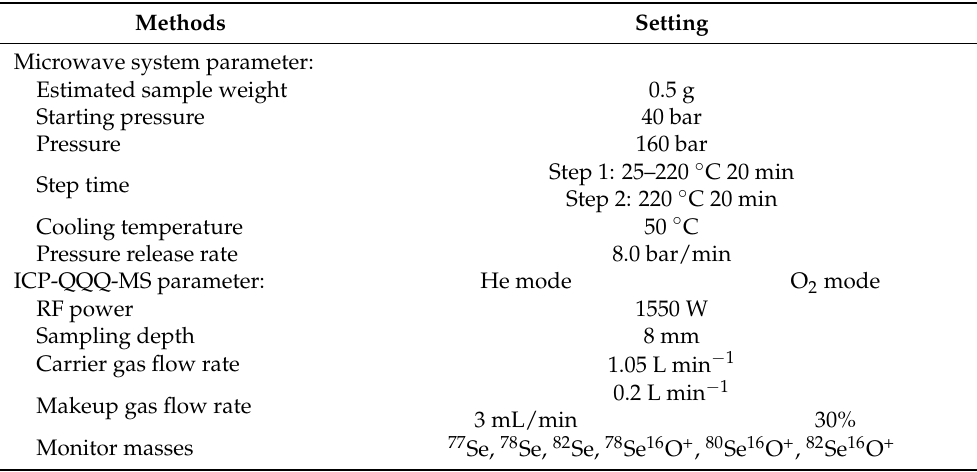
Table 2. Parameters used for digestion and analysis of